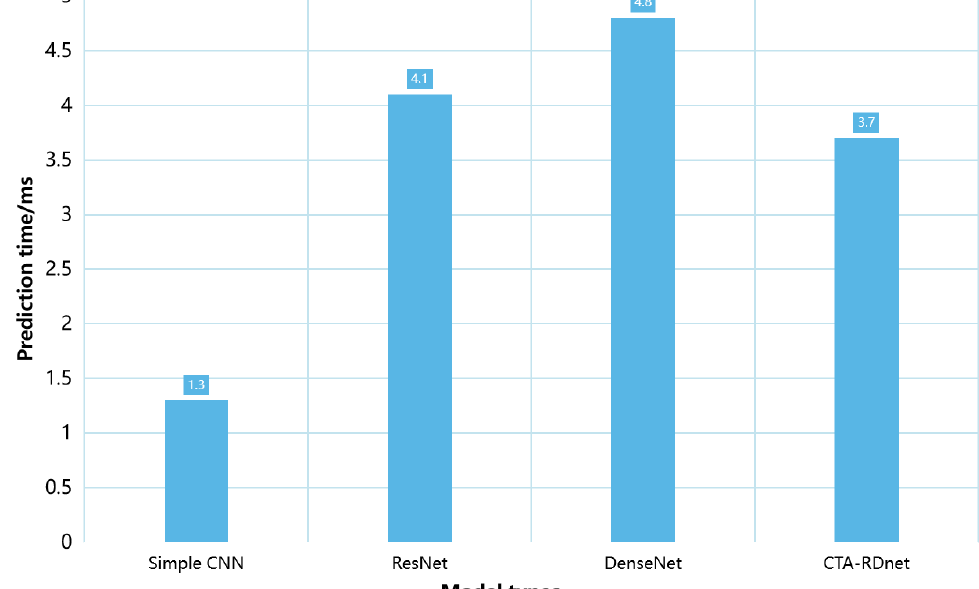
Figure 11. The ROC curve of the CTA-RDnet. Table 4. Experimental results of different models.